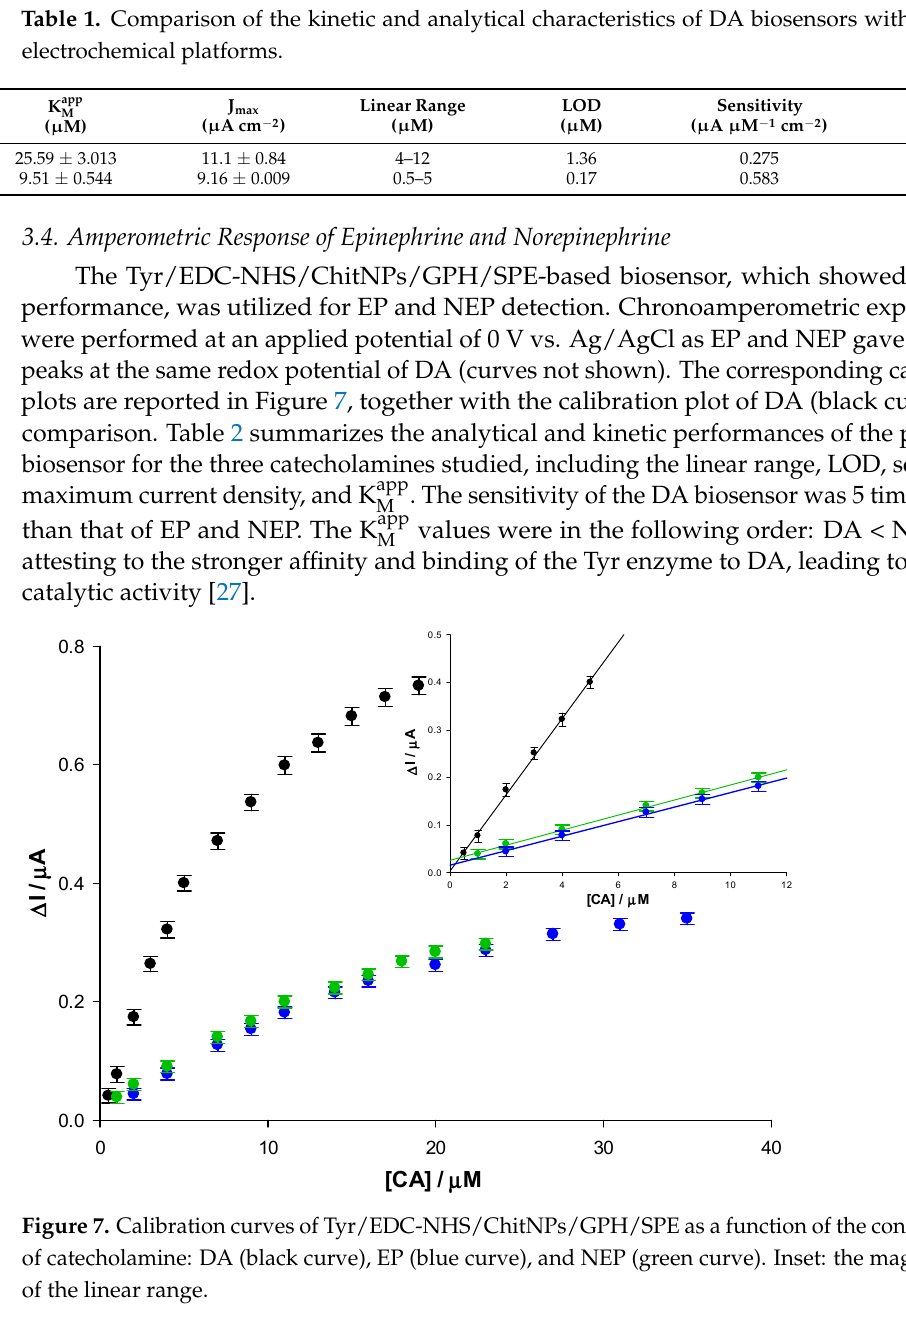
Table 1. Comparison of the kinetic and analytical characteristics of DA biosensors with different